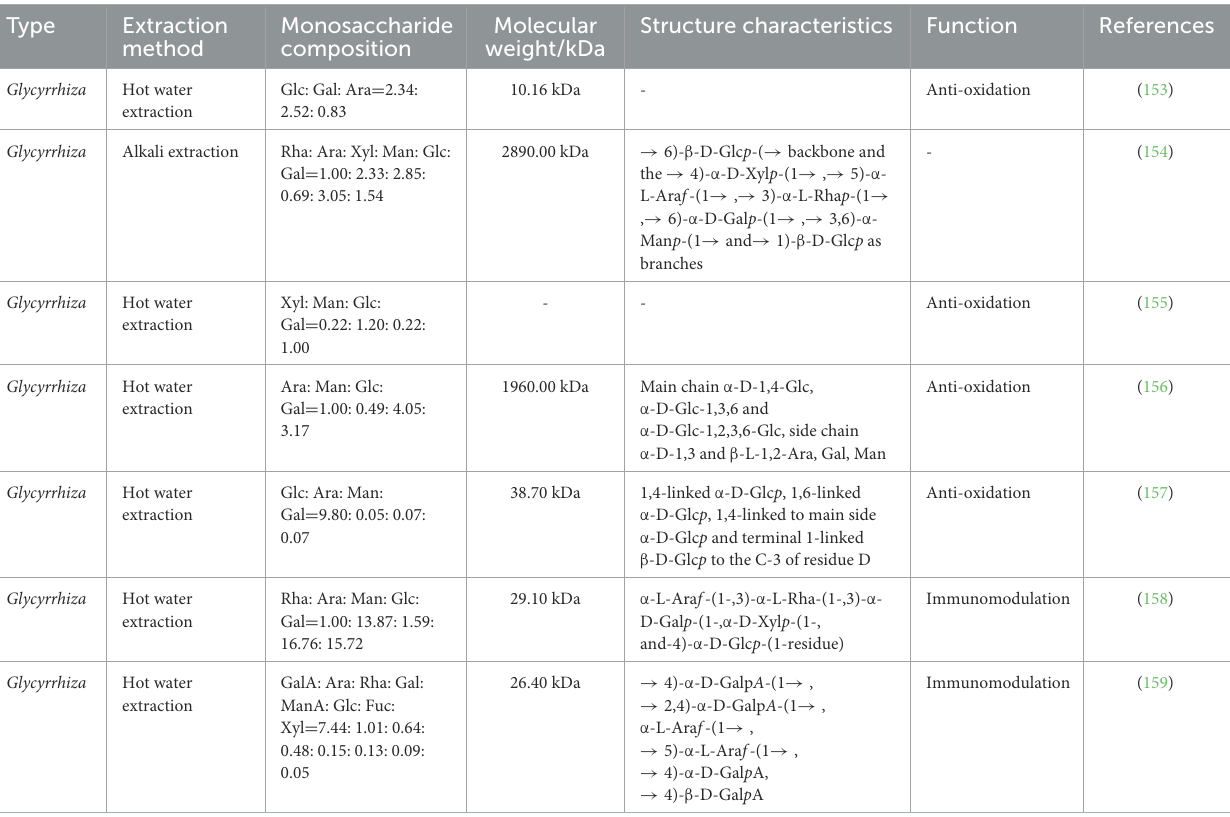
TABLE 9 Structure and structure-activity-relationship of polysaccharide from Glycyrrhiza . Type Extraction Monosaccharide Molecular Structure characteristics method composition weight/kDa